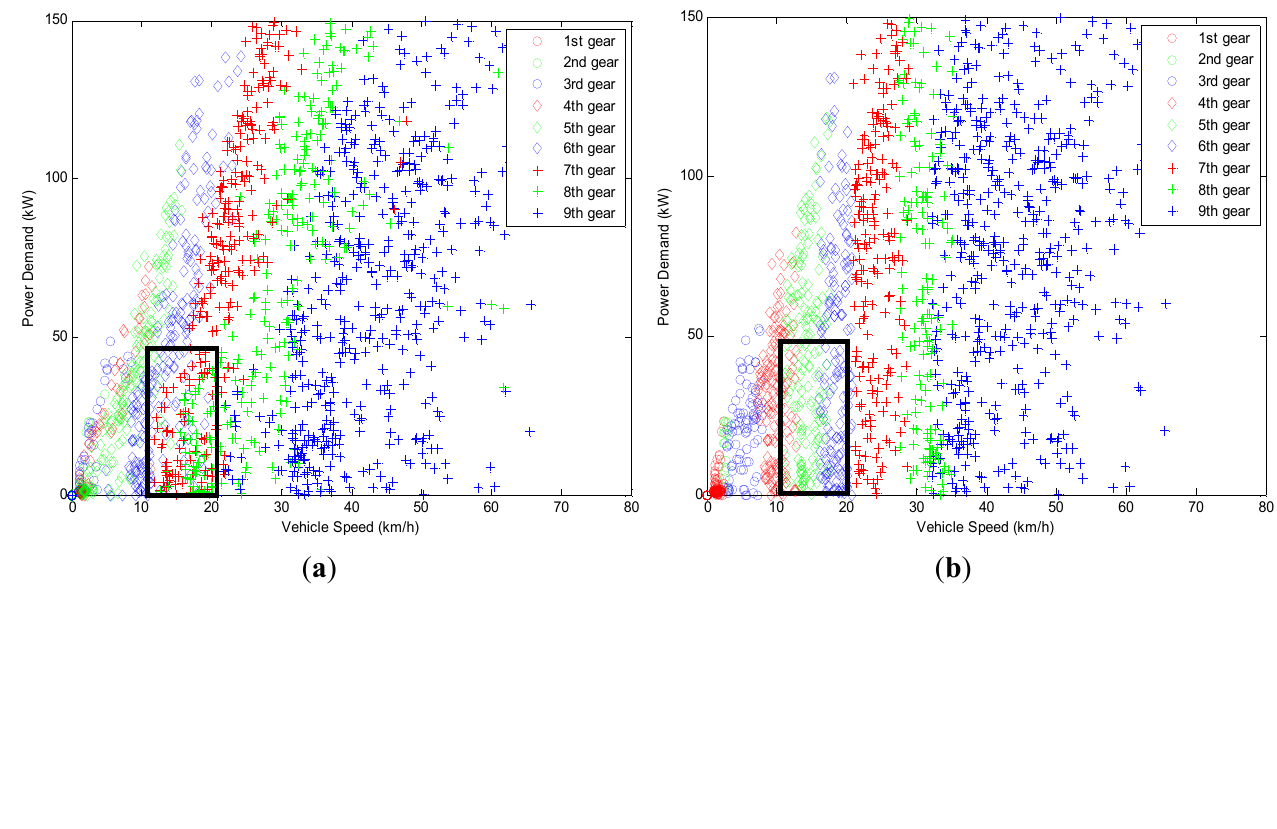
Figure 6. Gear distribution of DP and PMP. ( a ) Gear distribution of DP; ( b ) Gear distribution of